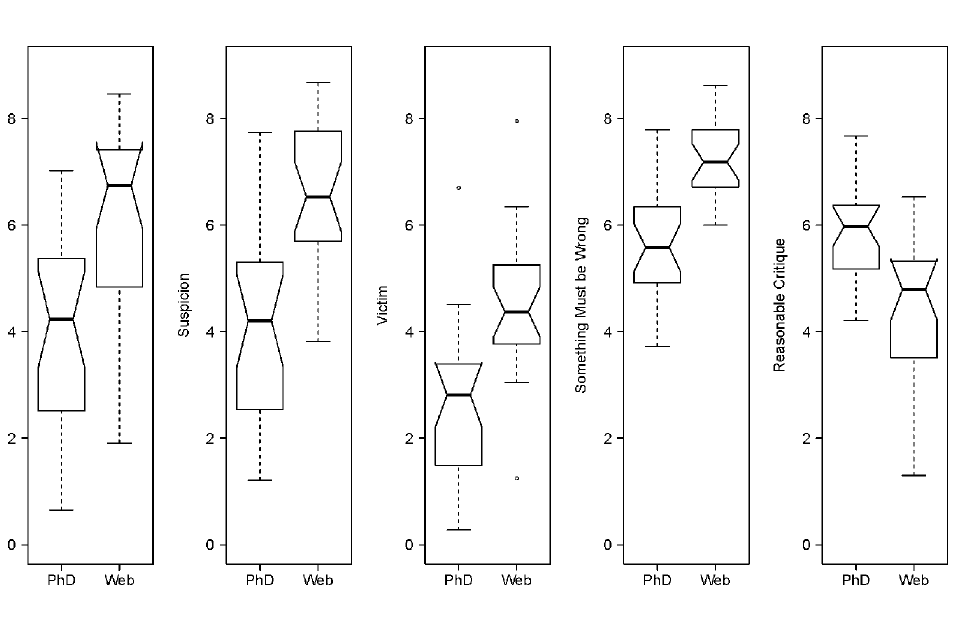
Figure 1. Summary of overall responses for all 5 measures in Study 3. Thick horizontal lines are medians, and medians differ significantly if the notches between boxes in each panel do not overlap. See Krzywinski and Altman (2014) for interpretative guidance of notched box